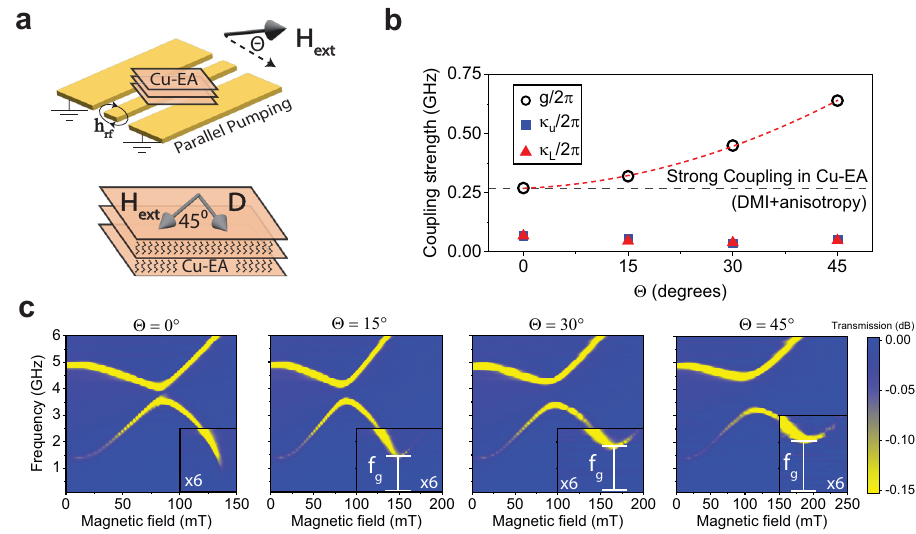
Fig. 3 | Enhanced magnon – magnon coupling strength. a Enhancement of the anticrossing gap by by rotating the external magnetic fi eld by an oblique angle Θ along the out-of-plane direction at45 (cid:4) to the in-plane principal a -axis as indicated. b Θ dependenceofthecouplingstrength g c andthedissipationratesfortheupper and lower magnonic branches, κ U and κ L derived from the frequency- fi eld